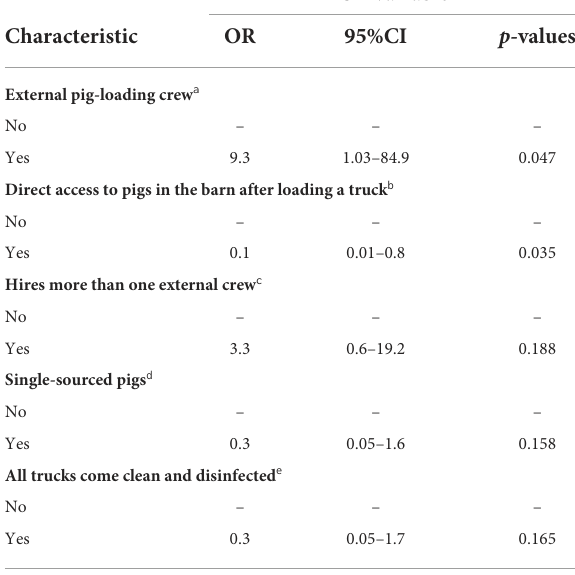
TABLE 3 Univariable logistic regression analysis of the risk factors associated with SVA seropositivity in U.S. growing pig farms.